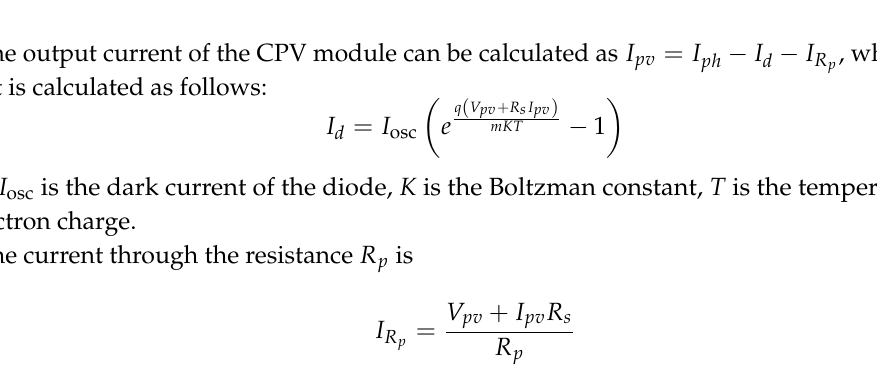
Figure 3. Electrical model for concentration photovoltaic (CPV)